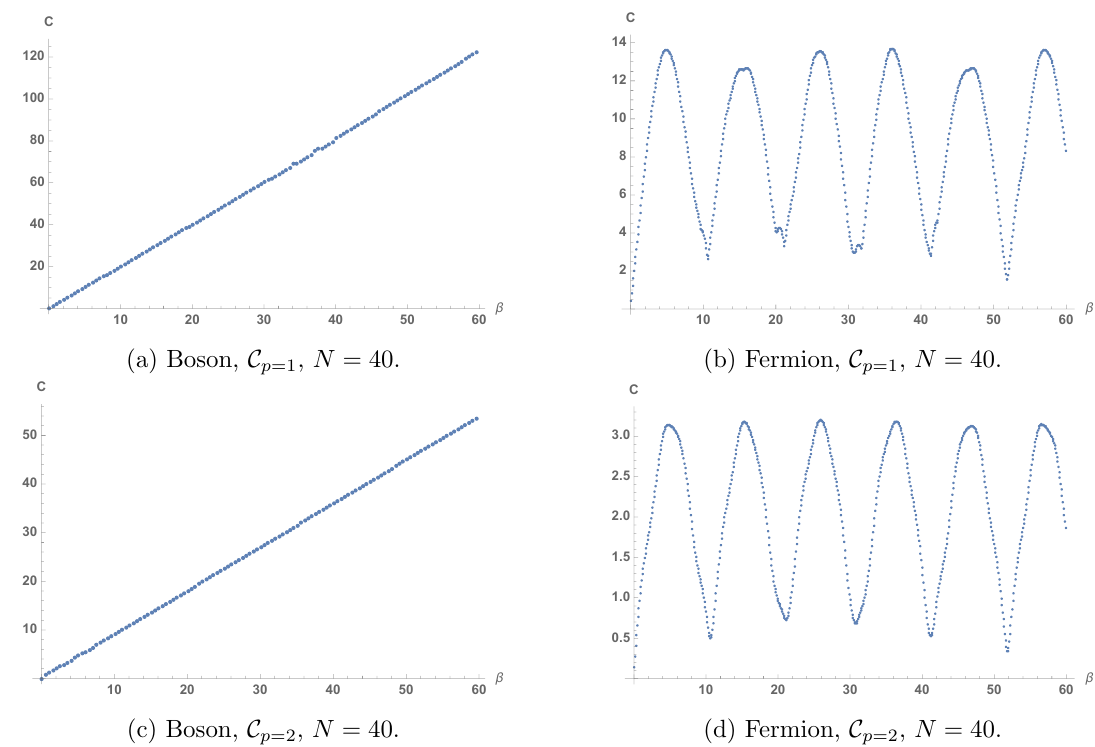
Figure 5. The complexity for bosonic and fermionic gaussian states with p = 1 and p = 2 norms. (a) and (c) represent the bosonic case while (b) and (d) represent the fermionic case. The cuto(cid:11) is chosen to be N = 40.